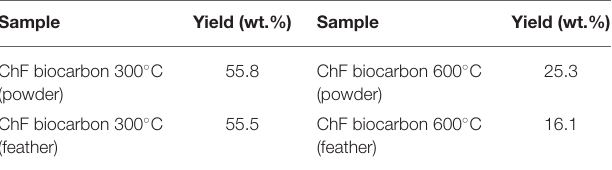
TABLE 1 | Yield content of ChF biocarbon.